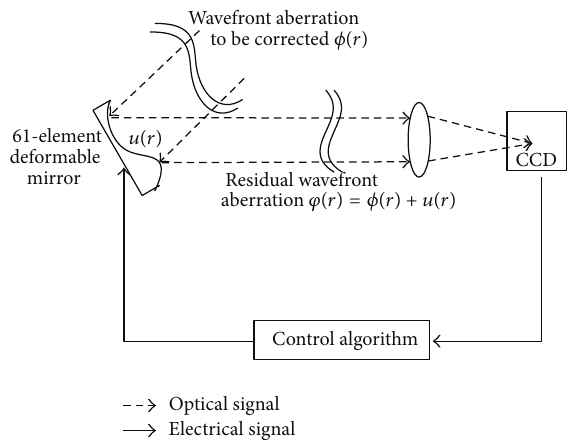
Figure 2: Block diagram of wavefront-sensorless adaptive optics system.